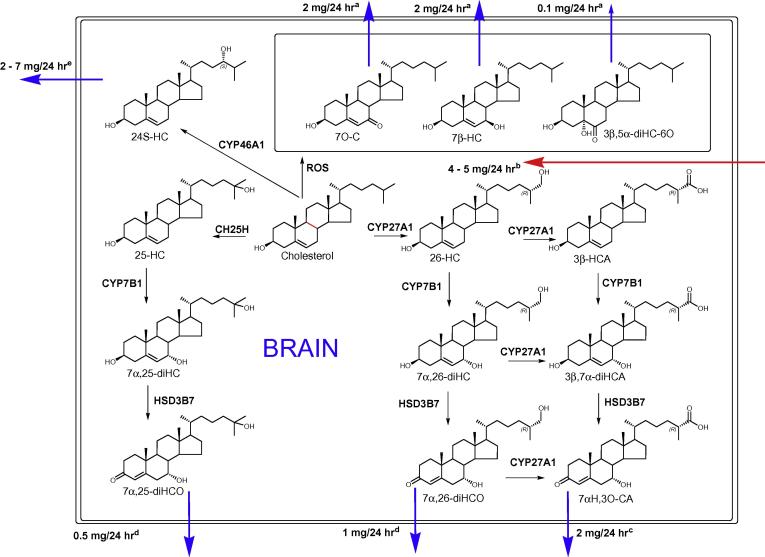
Cholesterol metabolism in brain. Cholesterol metabolites leaving and entering brain are indicated by arrows. Enzymes involved in cholesterol metabolism are shown. The metabolites within the boxed inset are likely formed through ROS. aPresent work. Formed via ROS. bFrom reference [6]. cFrom Ref. [9]. dFrom Ref. [19]. eFrom Refs. [3–6] and present work.